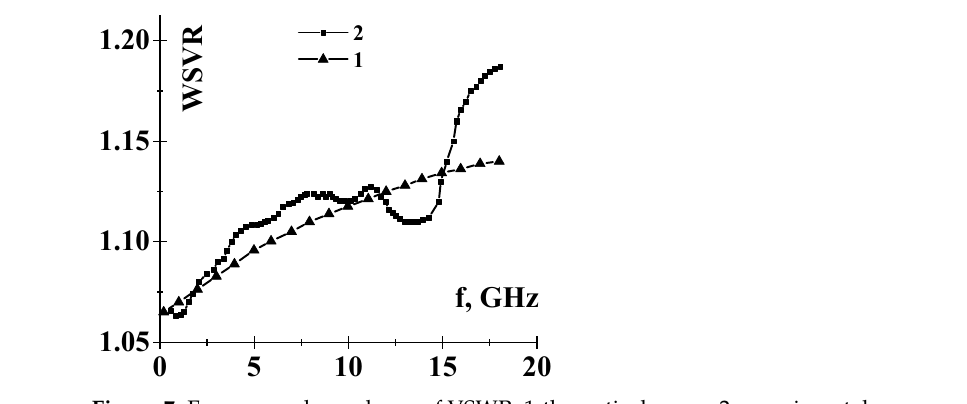
Figure 7. Frequency dependence of VSWR. 1-theoretical curve, 2-experimental curve.